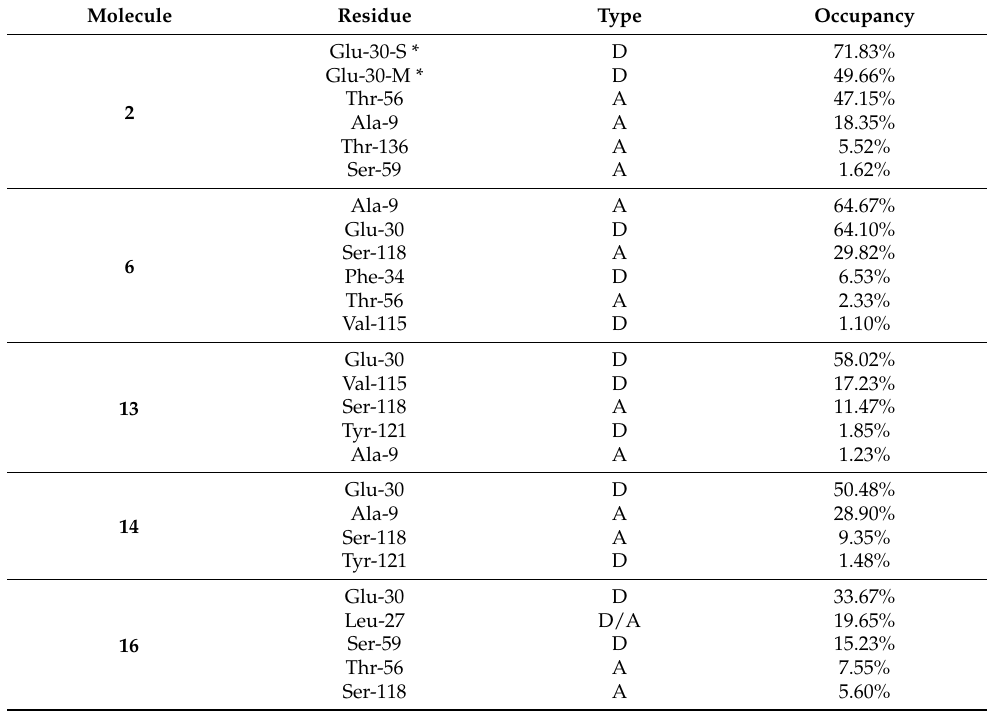
Table 2. List of H-bonds between the tested molecules and residues in the active site of h DHFR. Type of interaction indicates whether a ligand is a donor (D) or acceptor (A). Only residues with occupancy higher than one percent are presented. * A donor atom is carbonyl oxygen from the main chain (M) or carboxylate group from the side chain